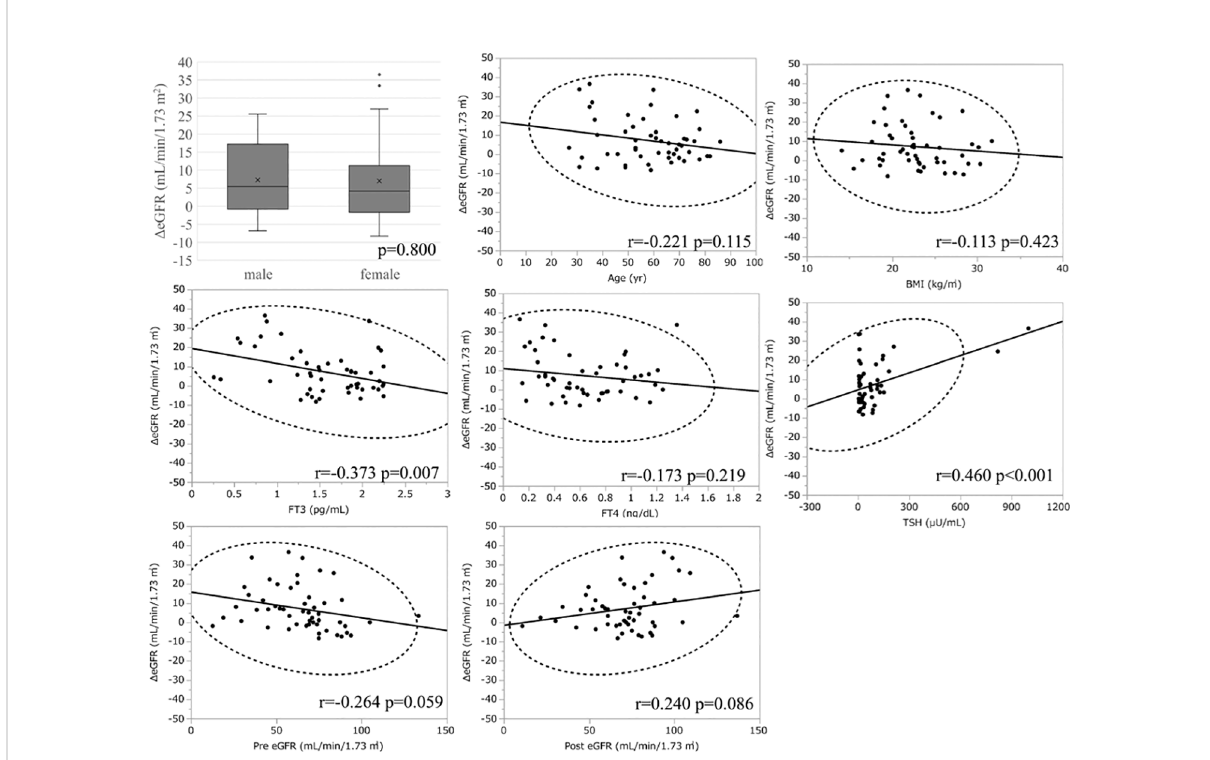
FIGURE 4 Association between D eGFR and variables in hypothyroidism. D eGFR of male and female, and scatter blot analysis between D eGFR and variables, age, gender, BMI, post-eGFR, pre-eGFR, FT3, FT4,